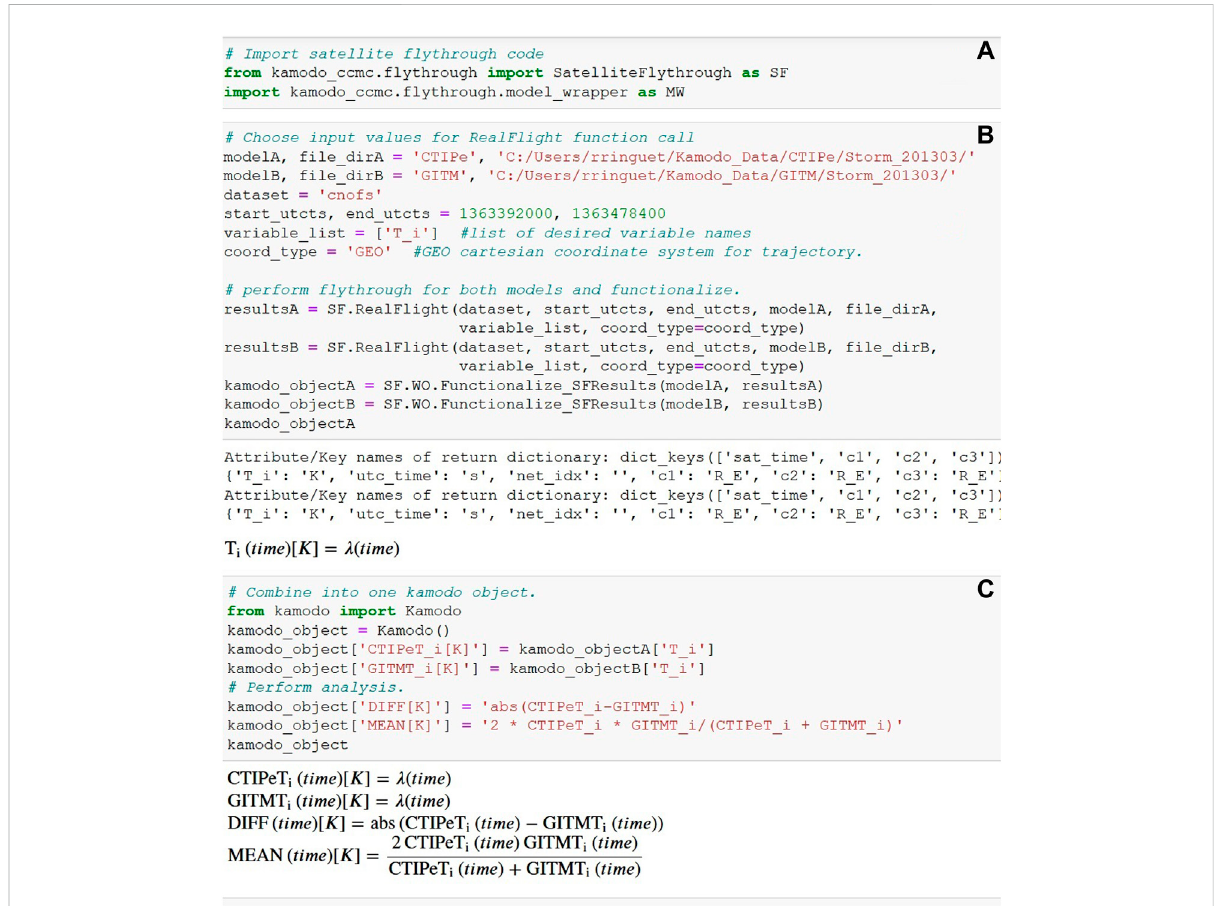
FIGURE 8 Example of ensemble modeling work fl ow. The fi rst two blocks (A and B) use Kamodo ’ s RealFlight function to fl y the chosen satellite trajectory through two simulation outputs. In the third block (C) , the functions are collected into a single Kamodo object for further computation via function